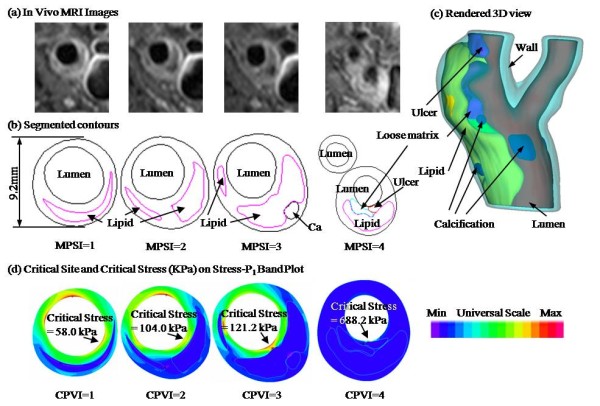
(a) In vivo MR-images (Lumen is marked by a red asterisk); (b) Segmented contour plots showing plaque components (Black: Lumen, vessel wall or calcification; Magenta: Lipid core; Red: Ulcer); (c): Rendered 3D view using the segmented contours; (d): Band plot of maximal principal stress (Stress-P1) of corresponding slices; CPSI values were calculated based on critical Stress-P1 values at critical sites, following procedures described in the paper.